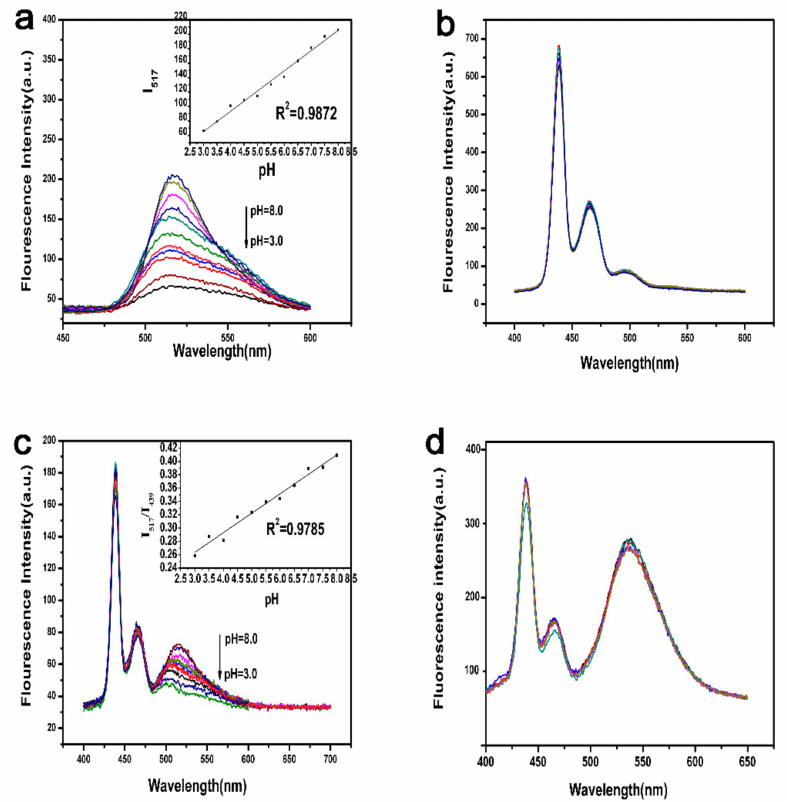
Figure 2. ( a ) Fluorescence emission spectra of FITC in pH 3.0–8.0 when excited at 488 nm, inset shows the linear correlation between the I 517 and the pH. ( b ) Fluorescence emission spectra of PFO Pdots in pH 3.0–8.0 when excited at 380 nm. ( c ) Fluorescence emission spectra of Pdots-PF in pH 3.0–8.0 when excited at 380 nm, inset shows the linear correlation between the I 517 / I 439 and the pH. ( d ) Fluorescence emission spectra of Pdots-PP in pH 3.0–8.0 when excited at 380